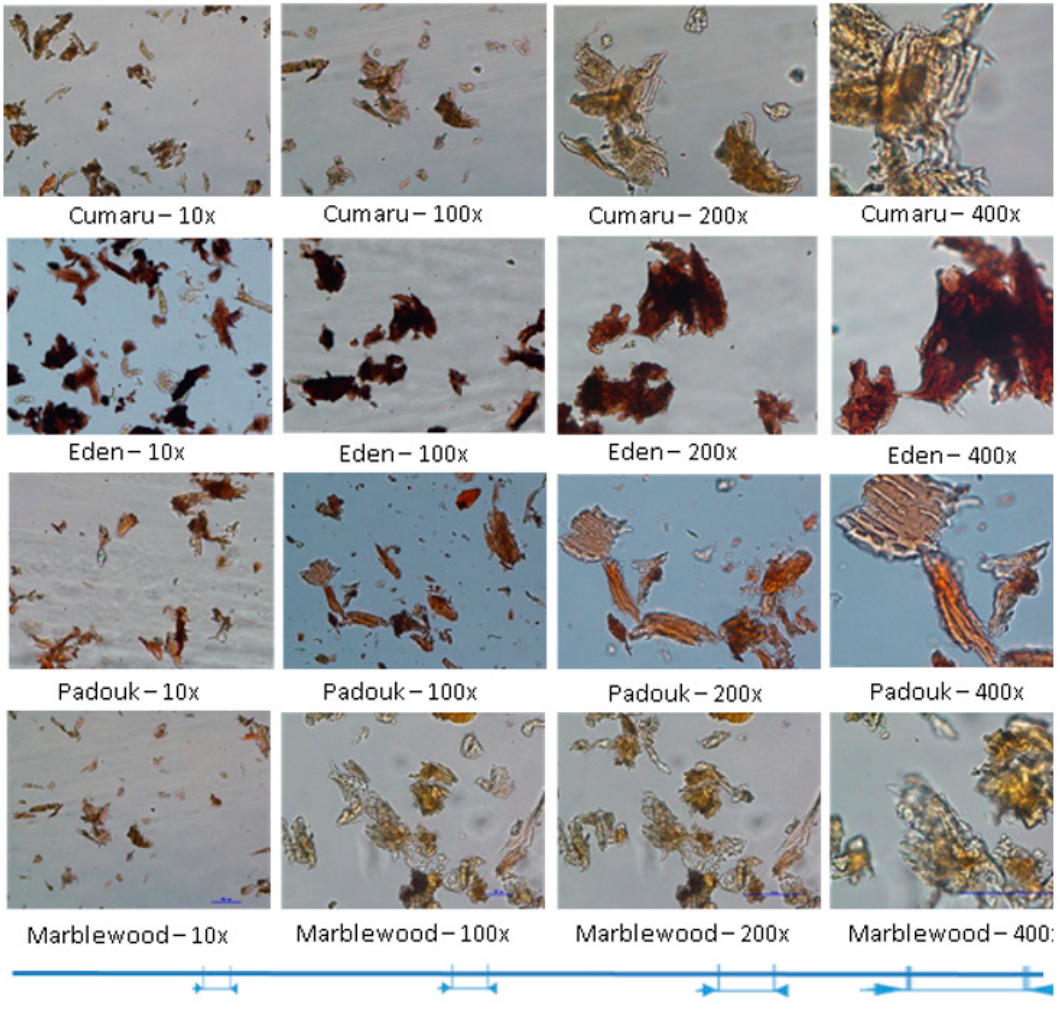
Figure 7. Light microscopic images of tropical dust fibers with 100 × , 200 × , and 400 × zoom. Legend: Blue line presents a size of 100 microns ( μ m) in a 2D layout.